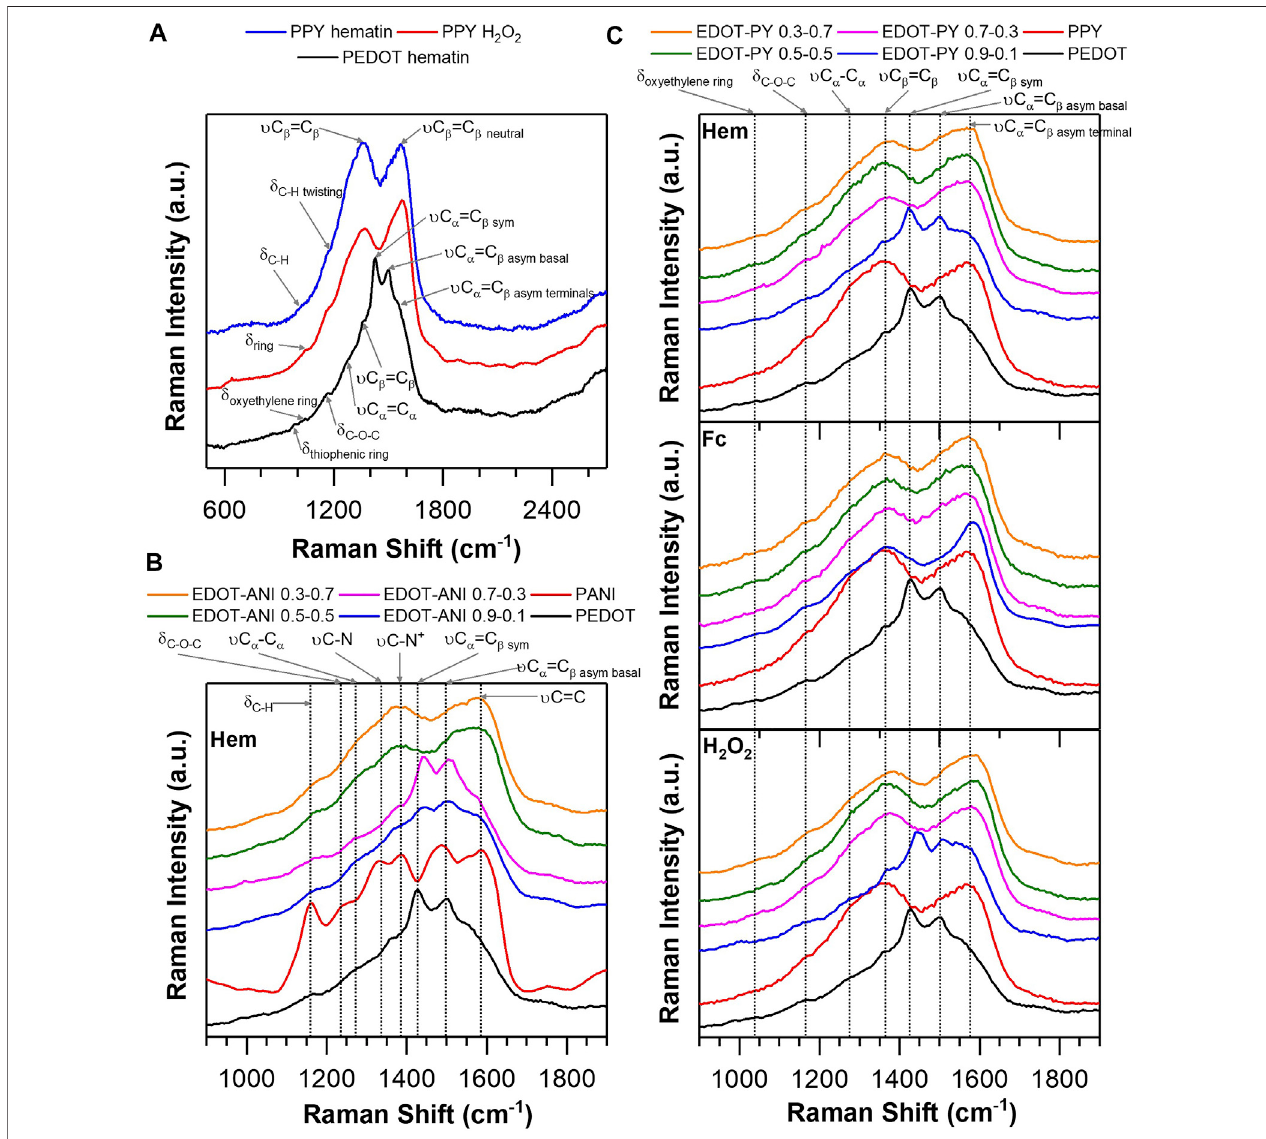
FIGURE3|(A) RamanspectraofPEDOTandPPYobtainedusingdifferentbiomimeticcatalysts, (B) RamanspectraofPANI,PEDOT,and EDOT-ANIcopolymers with different molar ratio obtained by biomimetic synthesis using hematin as catalyst, (C) Raman spectra of copolymers obtained using different biomimetic catalysts: EDOT-PY/Ferrocene, EDOT-PY/Hematin, EDOT-PY without catalyst.